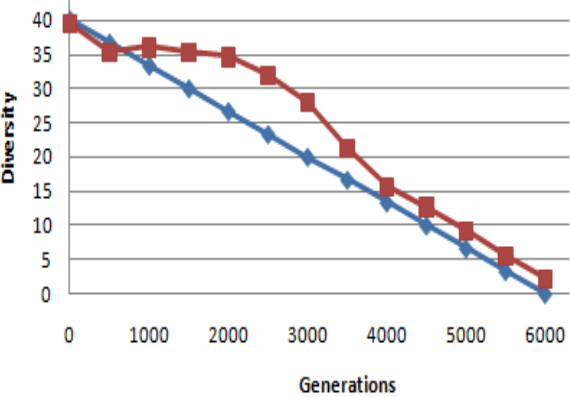
Figure 11. Diversity curve with thirty (30) generations.